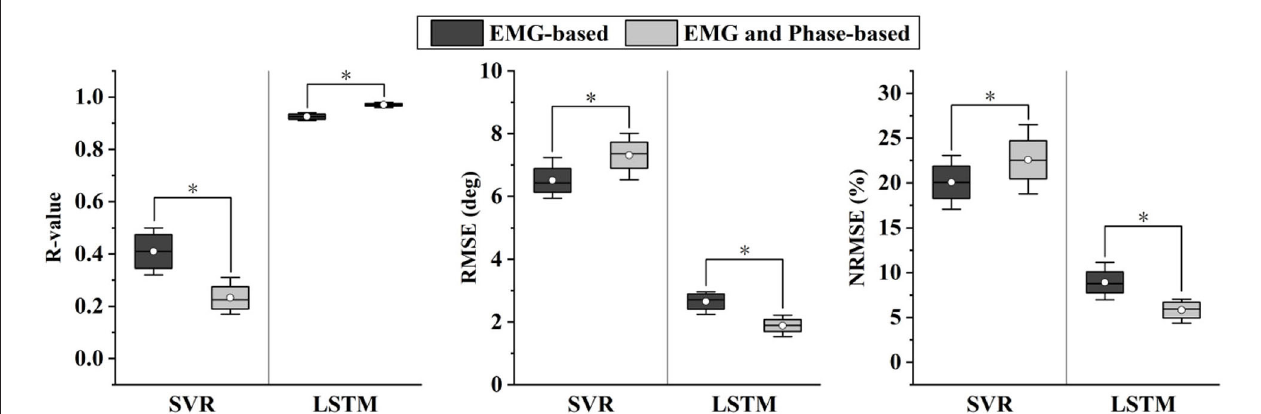
FIGURE 8 | The representative results of different ankle angle predictors.